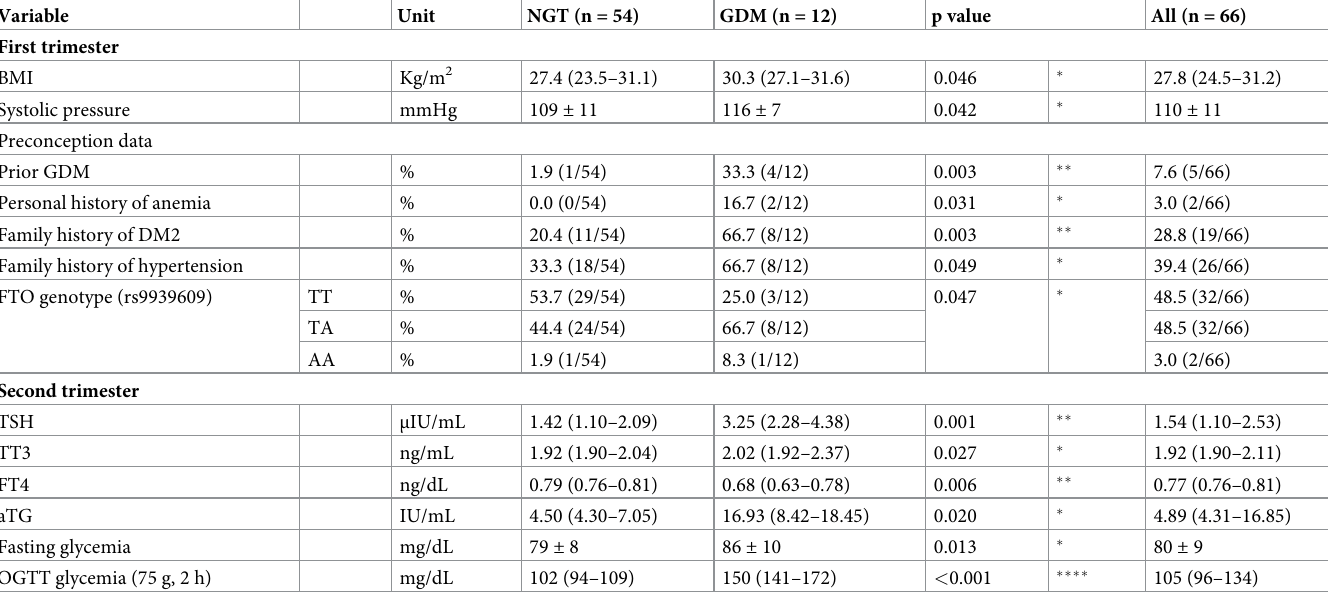
NGT: Normal glucose tolerance. GDM: Gestational diabetes mellitus. BMI: Body mass index. DM2: Type 2 diabetes. FTO: Fat mass and obesity-associated gene. TSH: Thyroid stimulating hormone. TT3: Total triiodothyronine. FT4: Free thyroxine. aTG: Thyroglobulin antibody. OGTT: Oral glucose tolerance test. Qualitative variables are presented as percentage (proportion); quantitative variables with normal distribution, as mean ± standard deviation; and quantitative variables with non-normal distribution, as median (interquartile range).